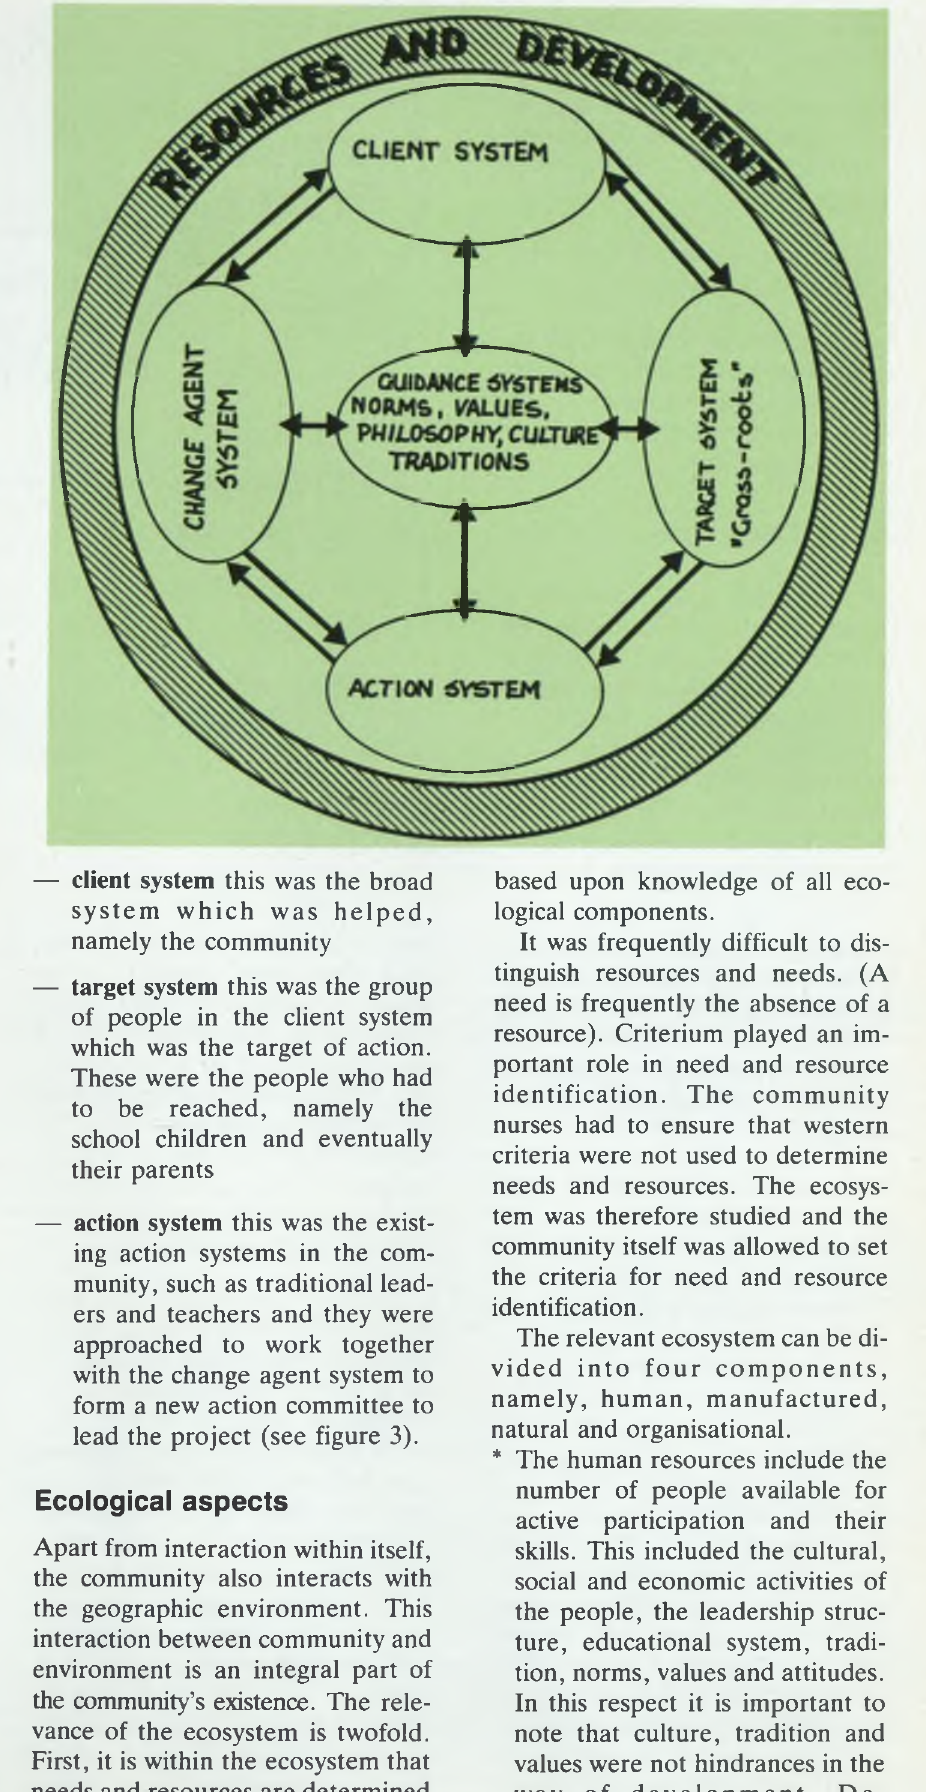
Figure 3 Systems involved with community development Mainly the phase of